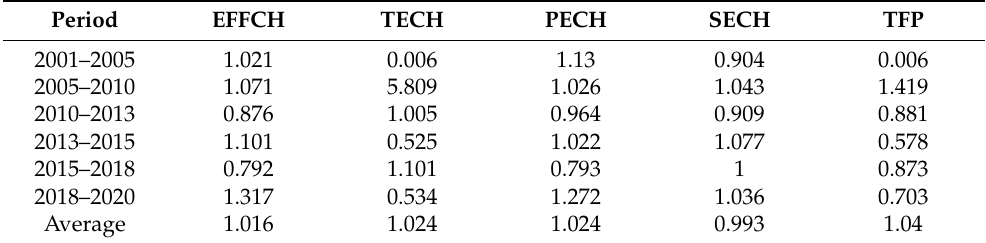
Table 5. Annual Variation Index and Decomposition Index of Zhejiang Province from 2000 to